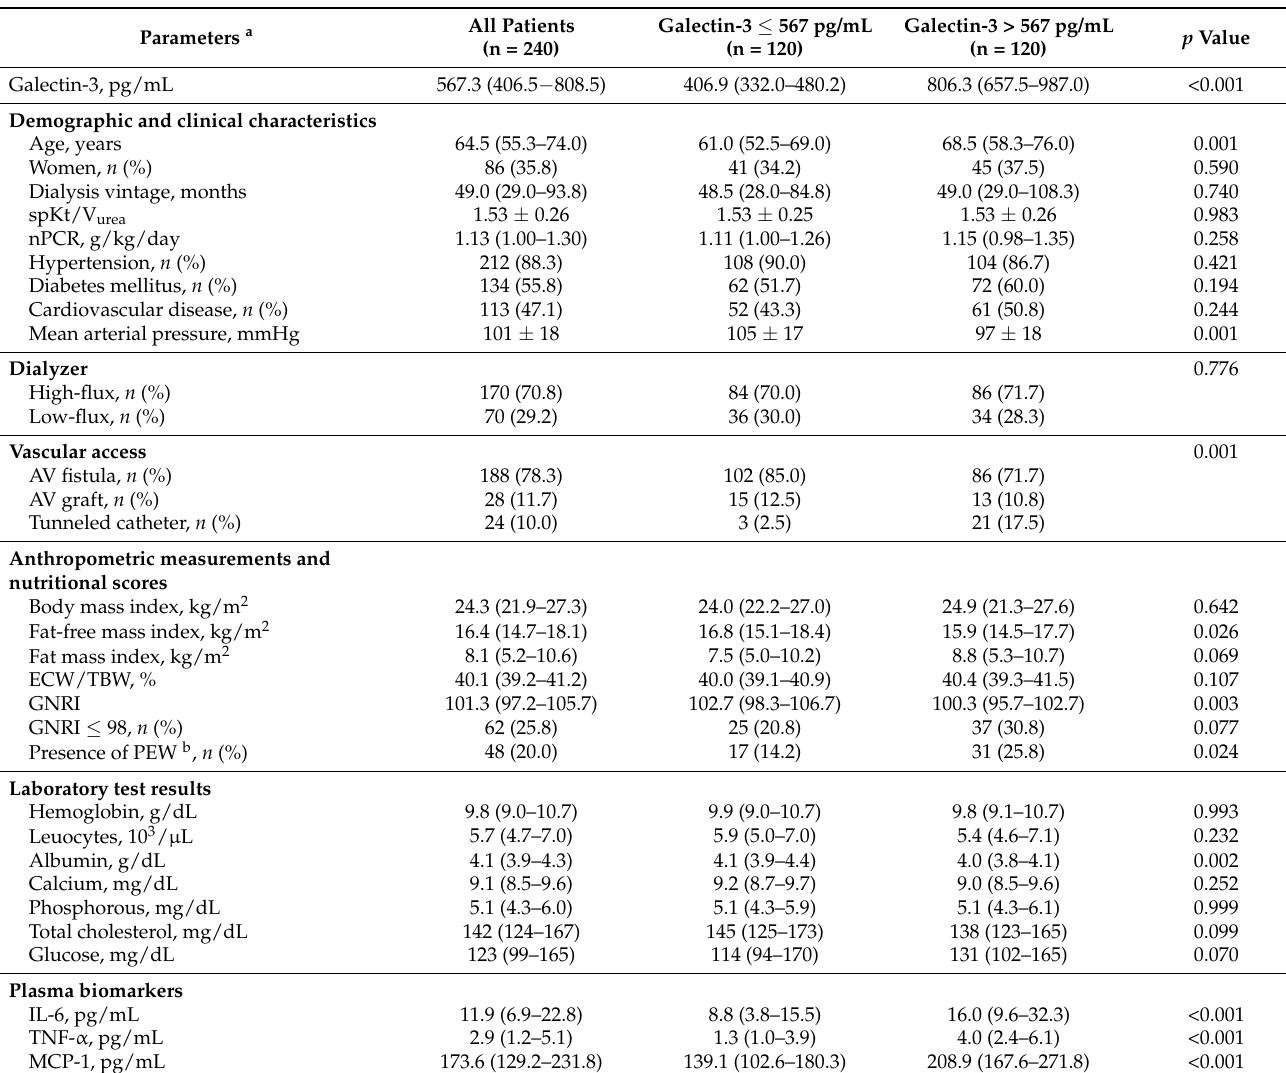
Table 1. Demographic, clinical characteristics and laboratory findings of maintenance hemodialysis patients stratified by the median plasma levels of